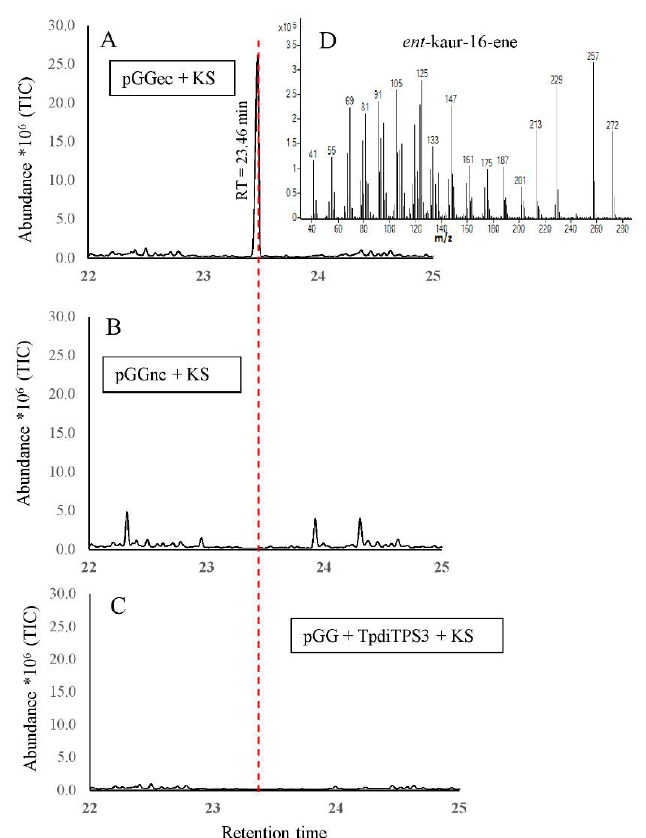
Figure 8. Confirmation of enantiospecific enzymatic product of TpdiTPS3. ( A ) = Expression of ent -CDP synthase with ent -specific kaurene synthase results in ent -kaur-16-ene biosynthesis. ( B ) = Expression of ent -specific kaurene synthase with normal CDP synthase did not yield any ent -kaur-16-ene. ( C ) = Expression of ent -specific kaurene synthase with GGDP synthase and TpdiTPS3 also did not yield ent -kaur-16-ene. ( D ) = Mass spectrum of ent -kaur-16-ene.